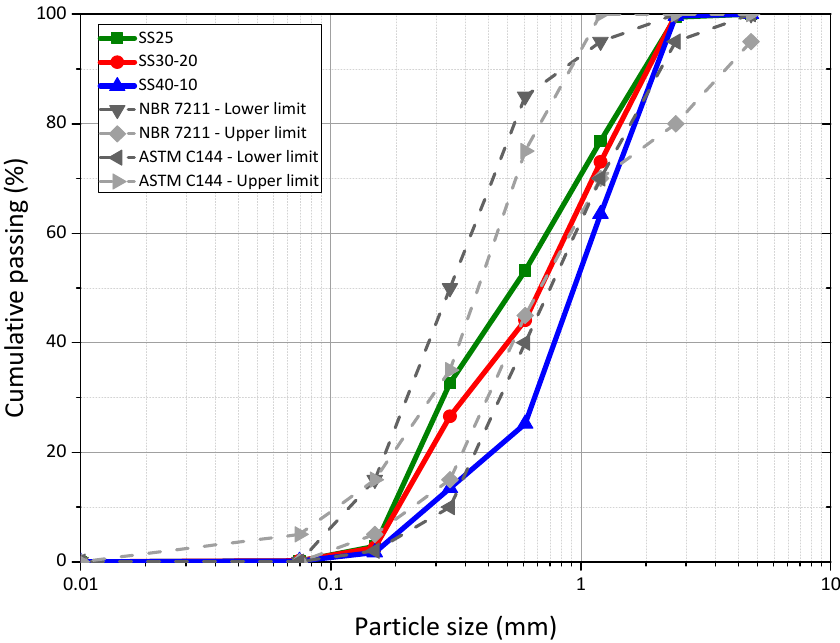
Figure 2. Sieve size curve of the sands studied and the respective normative limits.